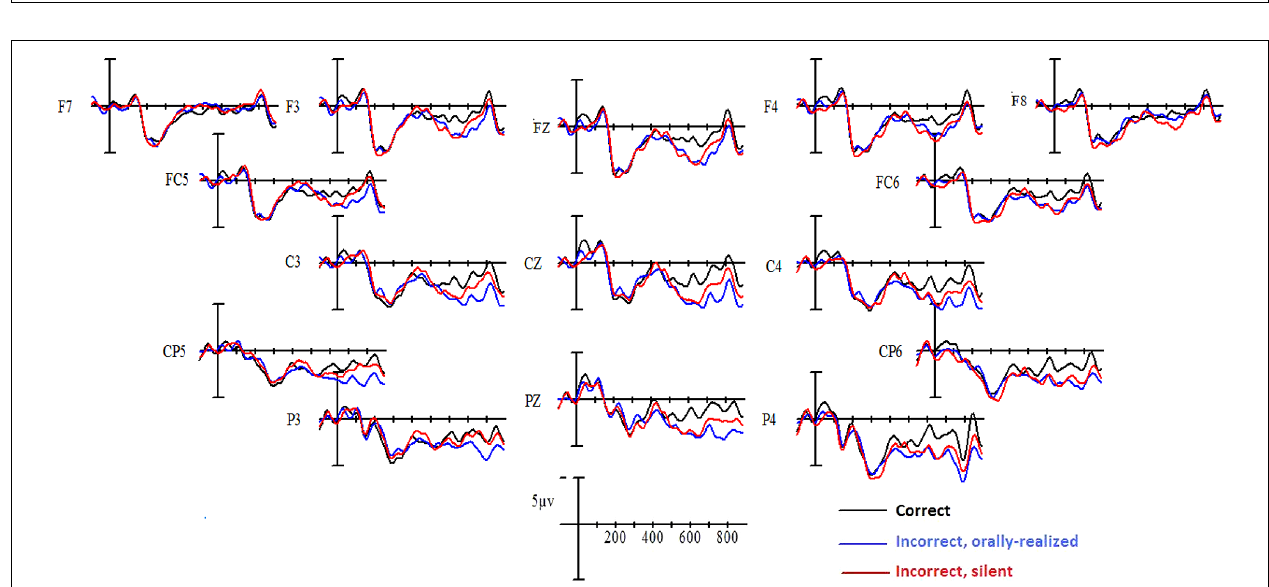
FIGURE 2 | Grand mean averages for Spanish L1–French L2 speakers as a function of verbal inflection condition and electrode site.